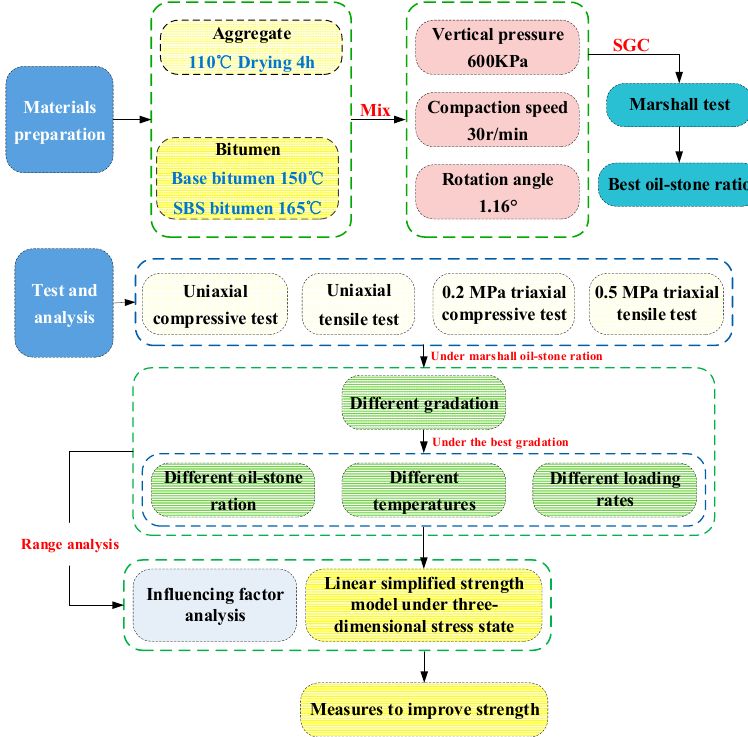
Figure 1. The research program of the failure strength models of asphalt mixtures under various